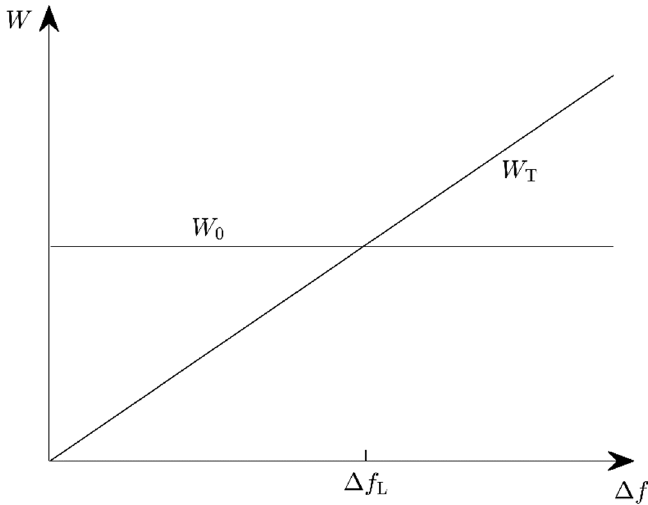
Figure 3. The possible harvested energy W 0 and required adjustment energy W T as functions of the frequency spacing Δ f between the harvester resonance frequencies before and after adjustment.